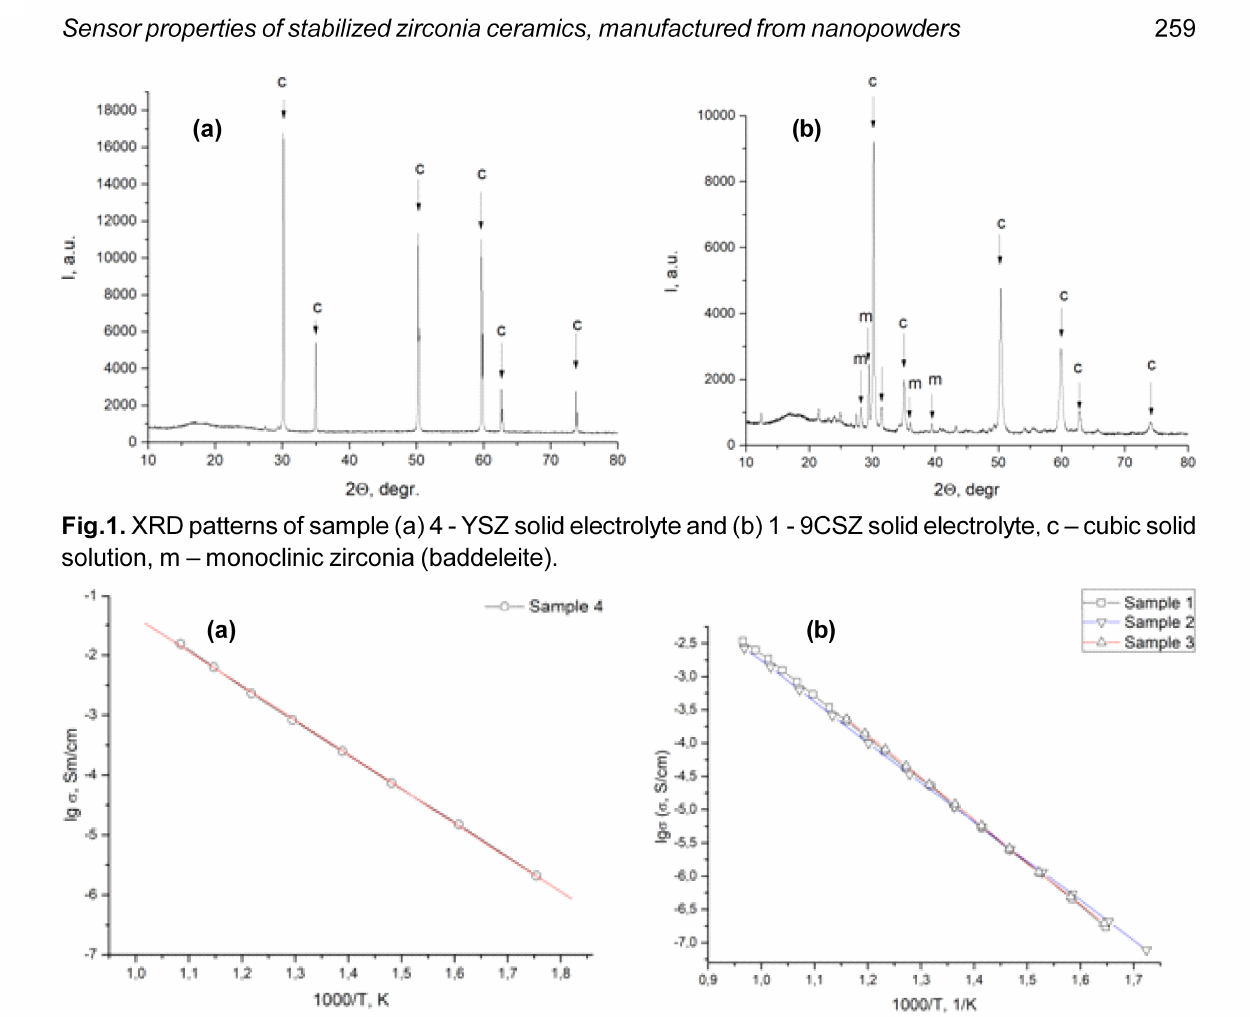
Fig. 2. Temperature dependencies of the integral conductivity obtained using impedance data for samples (a) 4 and (b) 1-3.